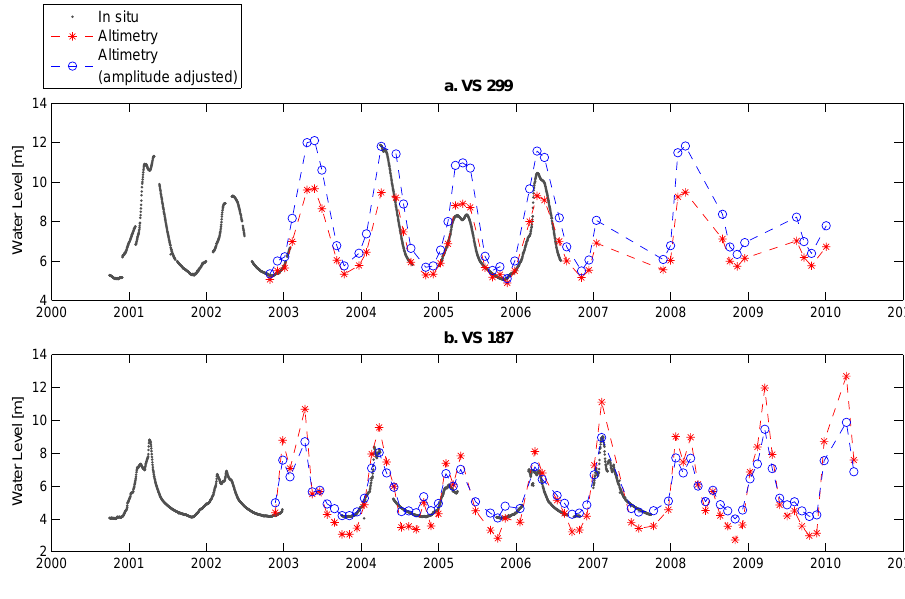
Fig. 2. Comparison of altimetry derived water levels and in situ water levels for VS 299 (a) and VS 187 (b) .